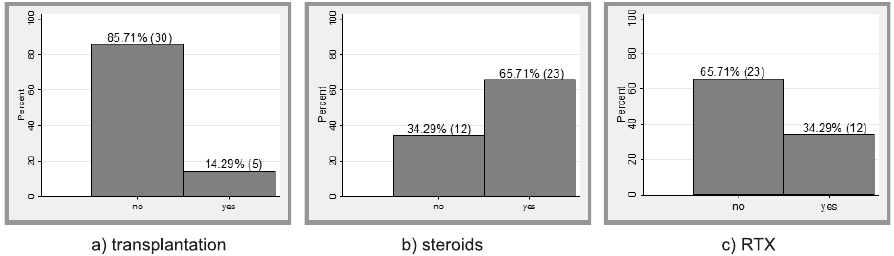
Figure 1. Indications of a) bone marrow transplantation; b) taking steroids;